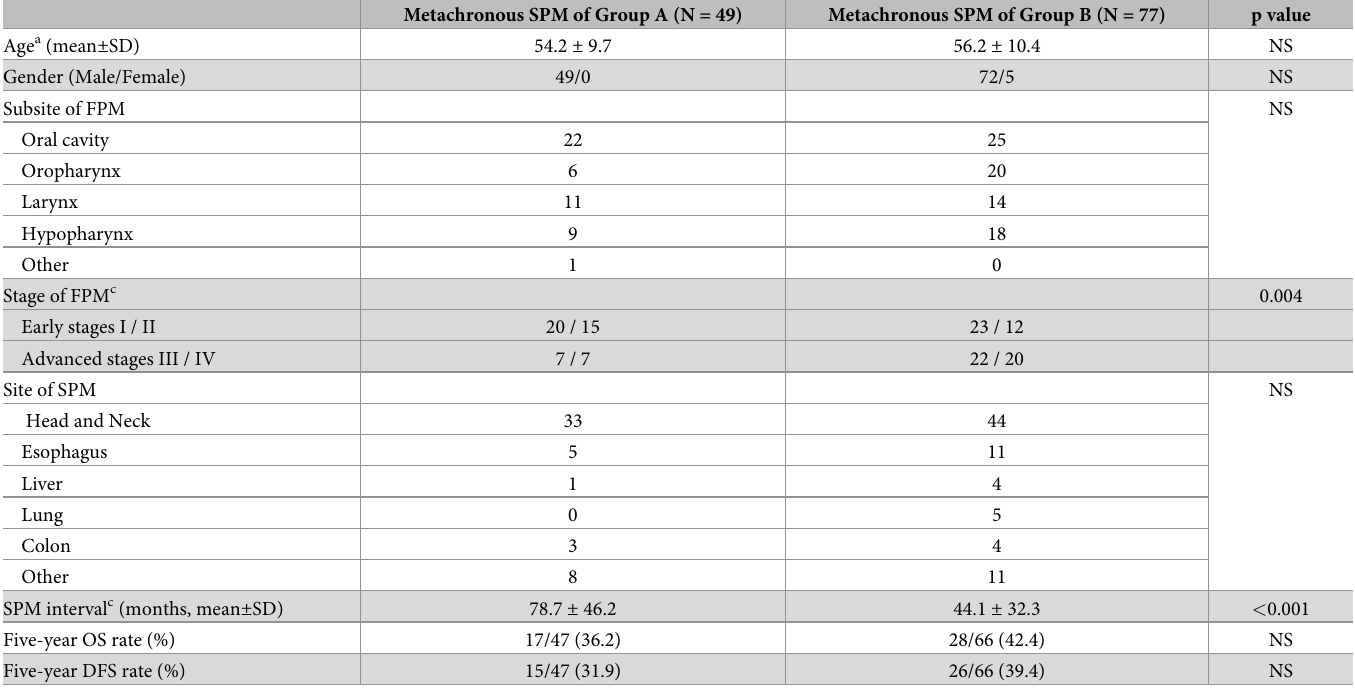
Table 2. Demographic and clinical characteristics in HNSCC patients with metachronous SPM of Group A and Group B.